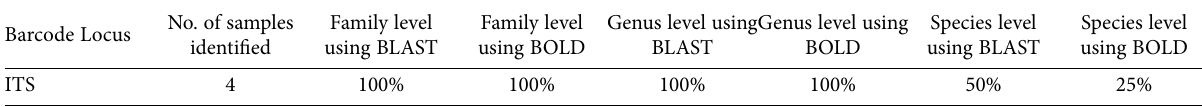
Table 6. Identification matches of the ITS sequences using the BLAST and BOLD Databases.